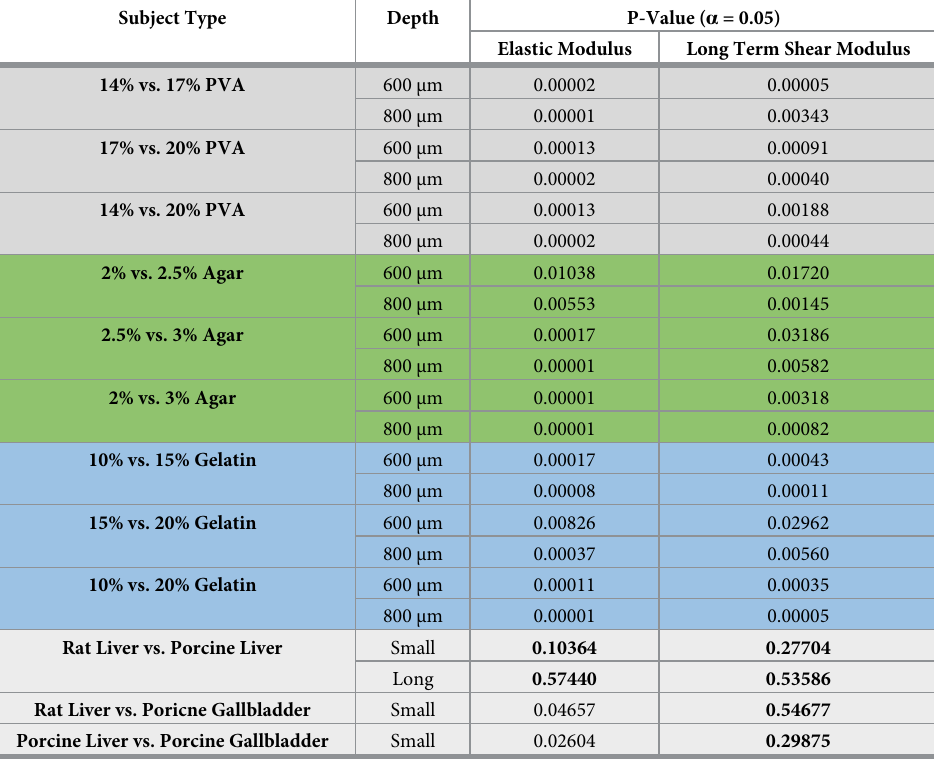
Table 3. Two-tailed T-test statistical analysis of elastic modulus and long term shear modulus of TMPs and ex vivo tissue specimen ( α = 0.05). The Small Depth corresponds to the lower indentation depth measurement of each tissue, while the Long Depth corresponds to the higher. Porcine gallbladder was only indented at one depth due to its small